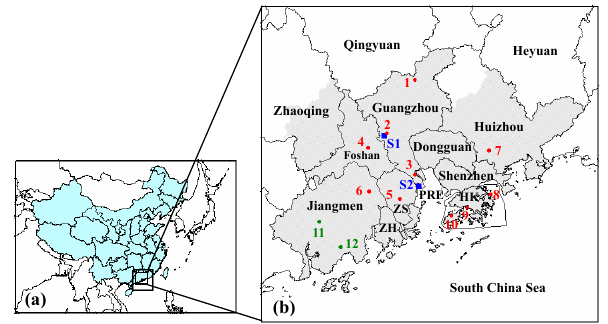
Fig. 1. (a) The 36-, 12-, and 4-km domains for CMAQ simula- tion; (b) locations of monitoring sites in the 4-km domain. Two su- per sites are labeled in blue: S1-GDEMC, S2-Xinken; the PRD air quality monitoring networks are labeled in red numbers: 1-Tianhu, 2-Luhu, 3-Wanqingsha, 4-Huijingcheng, 5-Zimaling, 6-Donghu, 7- Jinguowan, 8-Tap Mun, 9-Tsuen Wan, and 10-Tung Chung; the sites labeled in green numbers (11-Kaiping and 12-Duanfen) are used to investigate the air quality in the southwestern inland and coastal areas of the PRD, although no observation data were col- lected at these sites during the PRIDE-PRD2004 campaign. The PRD region is the gray area on the map; the names of some sub- regions are abbreviated: ZS-Zhongshan, ZH-Zhuhai, HK-Hong Kong, PRE-Pearl River